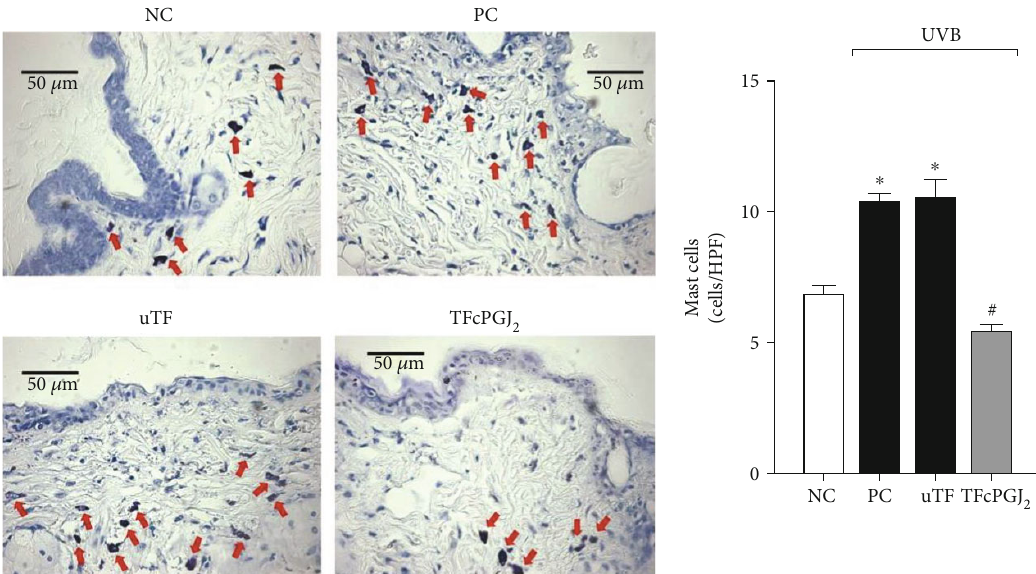
Figure 7: Topical formulation containing 15d-PGJ (TFcPGJ ) inhibits UVB irradiation-induced mast cell counts. Mast cell (red arrows) 2 2 counts were evaluated using toluidine blue in skin samples collected 12 h after the irradiation and were examined using light microscopy at 40x magni fi cation. NC: negative control; PC: positive control; uTF: unloaded topical formulation. Bars are means ± SEM of 6 mice per group and are representative of two separate experiments. One-way ANOVA followed by Tukey ’ s test. ∗ p < 0 : 05 versus the negative control group; # p < 0 : 05 versus UVB-stimulated groups.